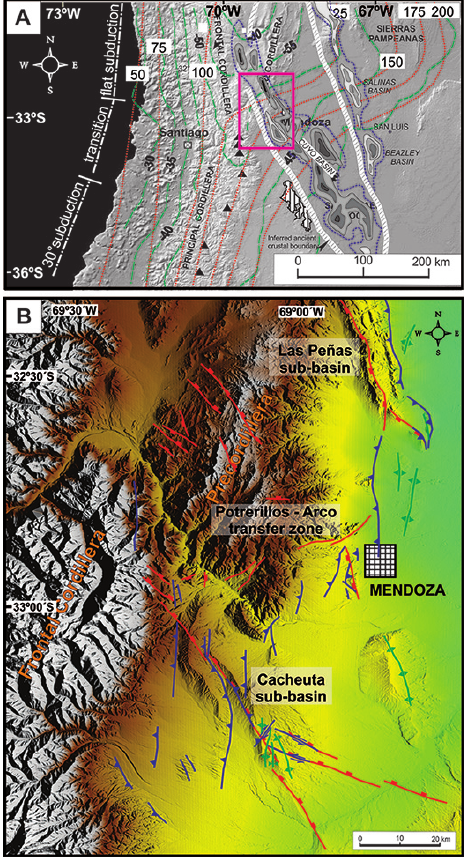
Figure 1. (a) Shaded relief map of the southern Central Andes from 31 to 36 ◦ S, highlighting present-day Andean morphostruc- tural units of the Principal Cordillera , Frontal Cordillera and Pre- cordillera; Sierras Pampeanas; and Triassic rift basins with main sub-basins (shaded depocenters). Green dashed lines indicate the Moho thickness taken from Tassara and Echaurren (2012). Red dashed lines show the depth of the subducting Nazca plate after Cahill and Isacks (1992). White dashed line indicates the exten- sion of the Cuyo Basin at subsurface. The magenta rectangle in- dicates area of Fig. 1b. Note the location of the study area above the transitional zone between the flat and normal subduction seg- ments. (b) Detailed relief map of the southern termination of the Precordillera range (close to the city of Mendoza, Argentina), the eastern sector of the Frontal Cordillera, and the Cacheuta and Las Peñas sub-basins of the Cuyo Basin. Triassic rift-related structures are in red; Quaternary faults and folds are in black and green, re-